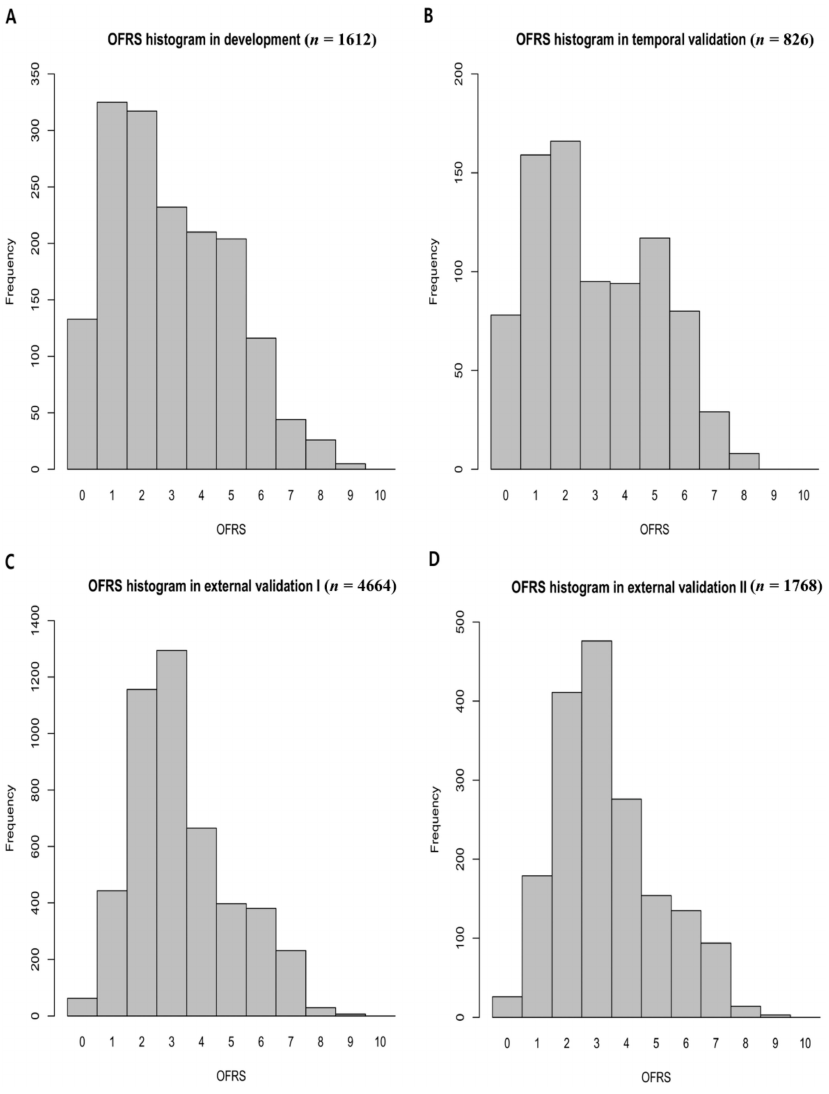
Figure 2. Distribution of the OFRS in ( A ) development cohort, ( B ) temporal validation cohort, ( C ) external validation cohort I, and ( D ) external validation cohort (cid:226) . The OFRS is distributed in the range of 0 to 10. OFRS, operation frailty risk